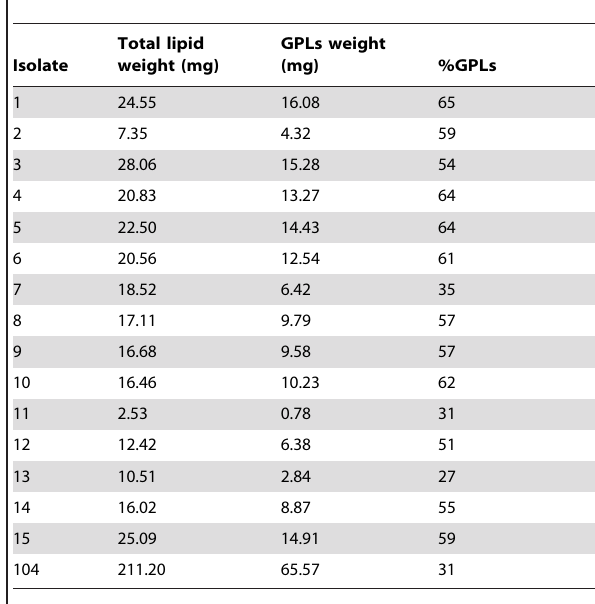
Table 2. Percentage of GPLs extracted.